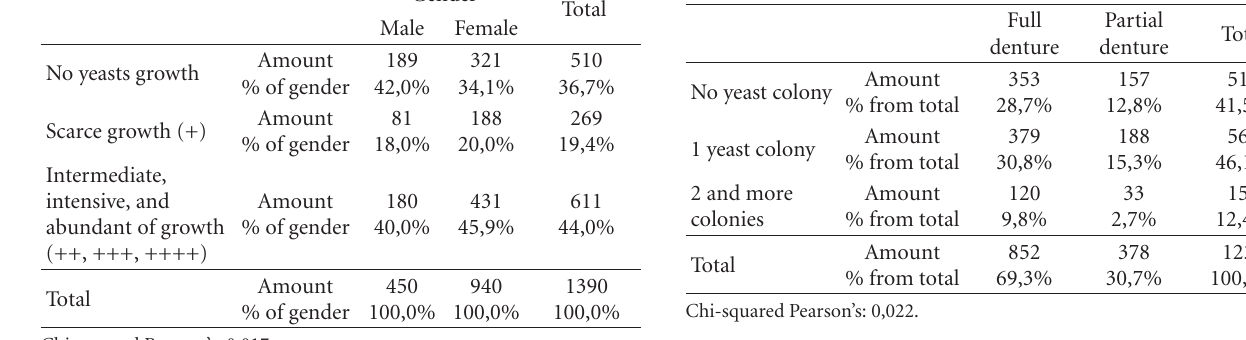
Table 11: Distribution of number of yeasts colony and no growth according to the type of